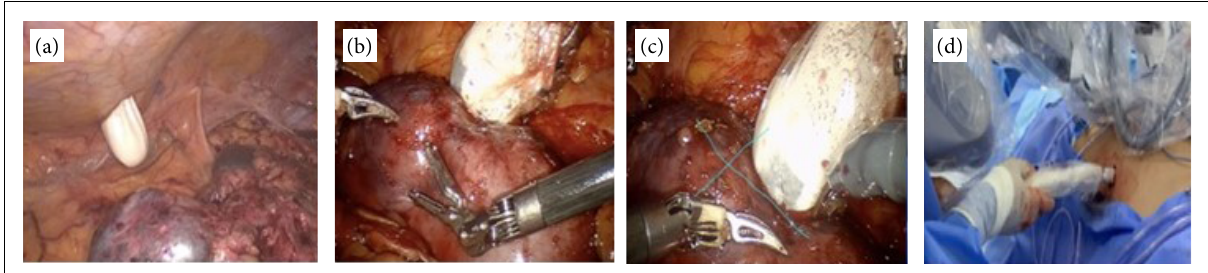
Figure 2 - Access and positioning of the endocavitary probe.